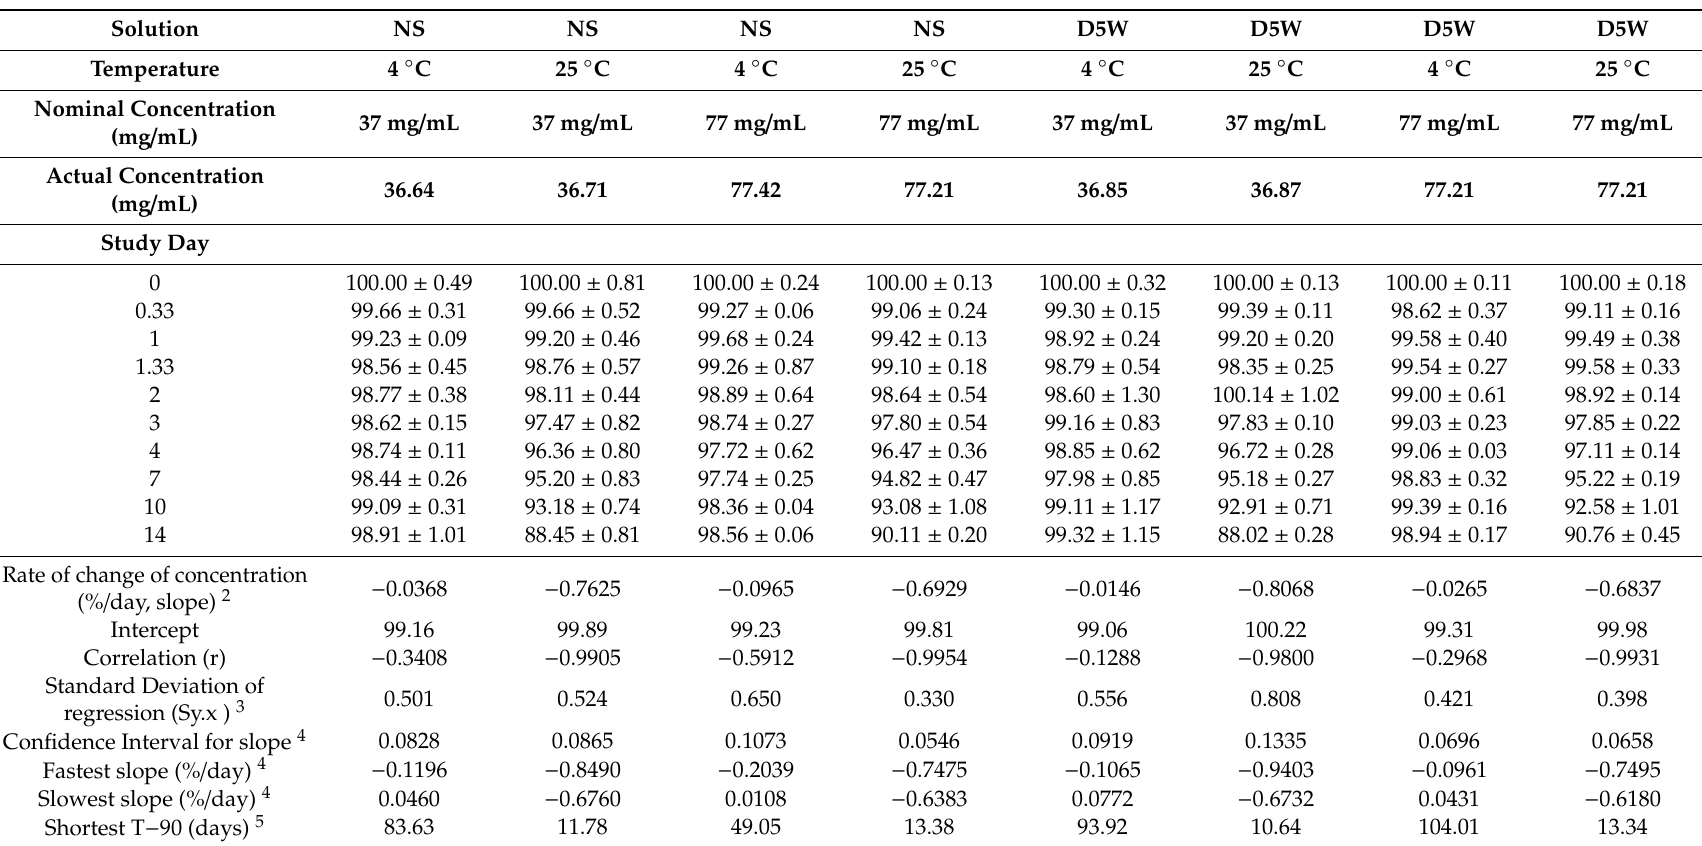
Table 1. Ascorbic acid (Source: Sandoz) initial concentrations and percentage remaining 1 on each study day with calculation of the time to achieve 90% remaining (T-90) with 95%